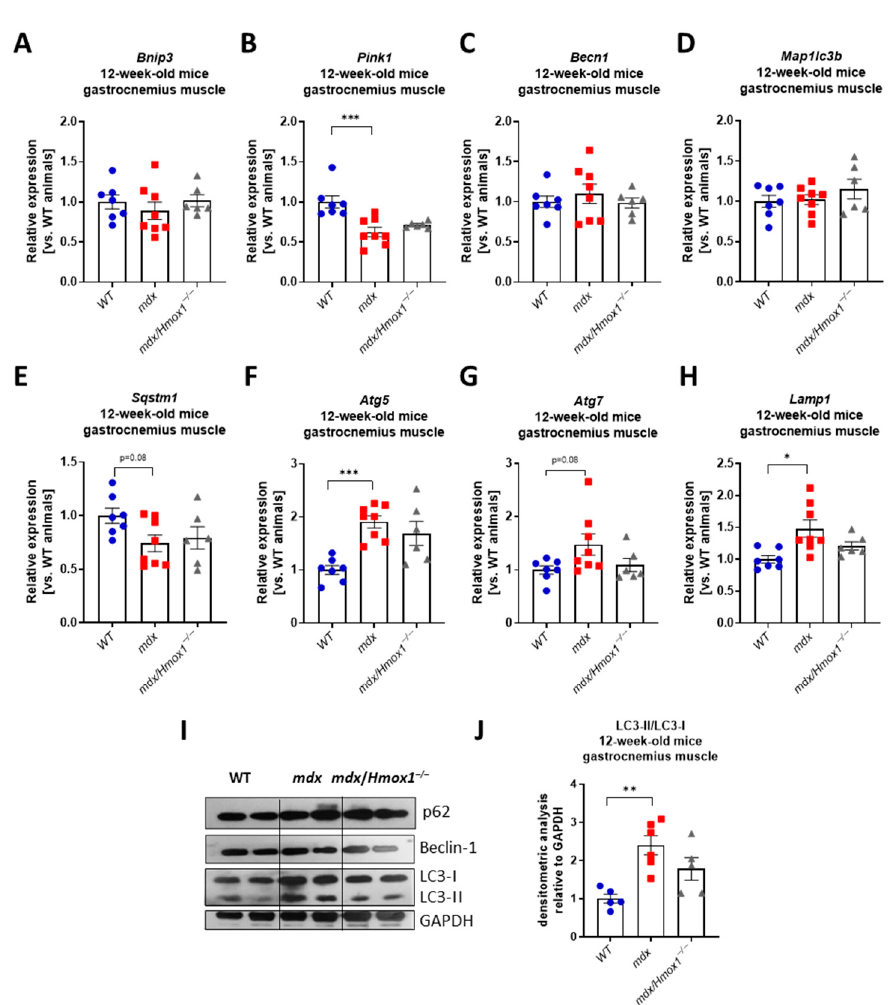
Figure 5. Expression of genes regulating mitophagy and autophagy in 12-week-old WT, mdx , and mdx / Hmox1 − / − mice. Analysis of mRNA level of genes regulating autophagy in gastrocnemius muscle. The expression of Bnip3 ( A ), Pink1 ( B ), Becn1 ( C ), Map1lc3b ( D ), Sqstm1 ( E ), Atg5 ( F ), Atg7 ( G ), and Lamp1 ( H ) was analyzed by qRT-PCR; n = 6–8/group. Western blot analysis of p62, Beclin-1, LC3- I, and LC3-II level ( I ) and densitometric analysis of LC3-II/LC3-I ratio ( J ), n = 5–6/group. GAPDH was used as a loading control. Results presented as mean ± SEM. * p < 0.05, ** p < 0.01, *** p < 0.005 by one-way ANOVA with Tukey’s post hoc